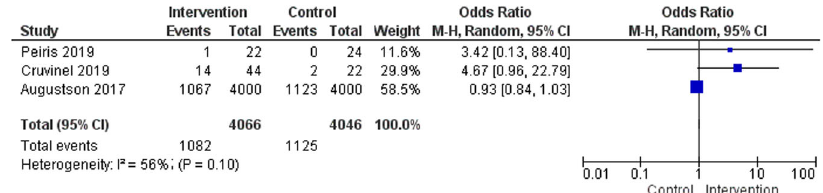
Fig. 7 Summary of culturally adapted IMI for smoking cessation vs. active controls in short-term. Three studies reported smoking cessation outcomes measuring short-term abstinence at the end of the intervention vs. active controls are presented on the forest